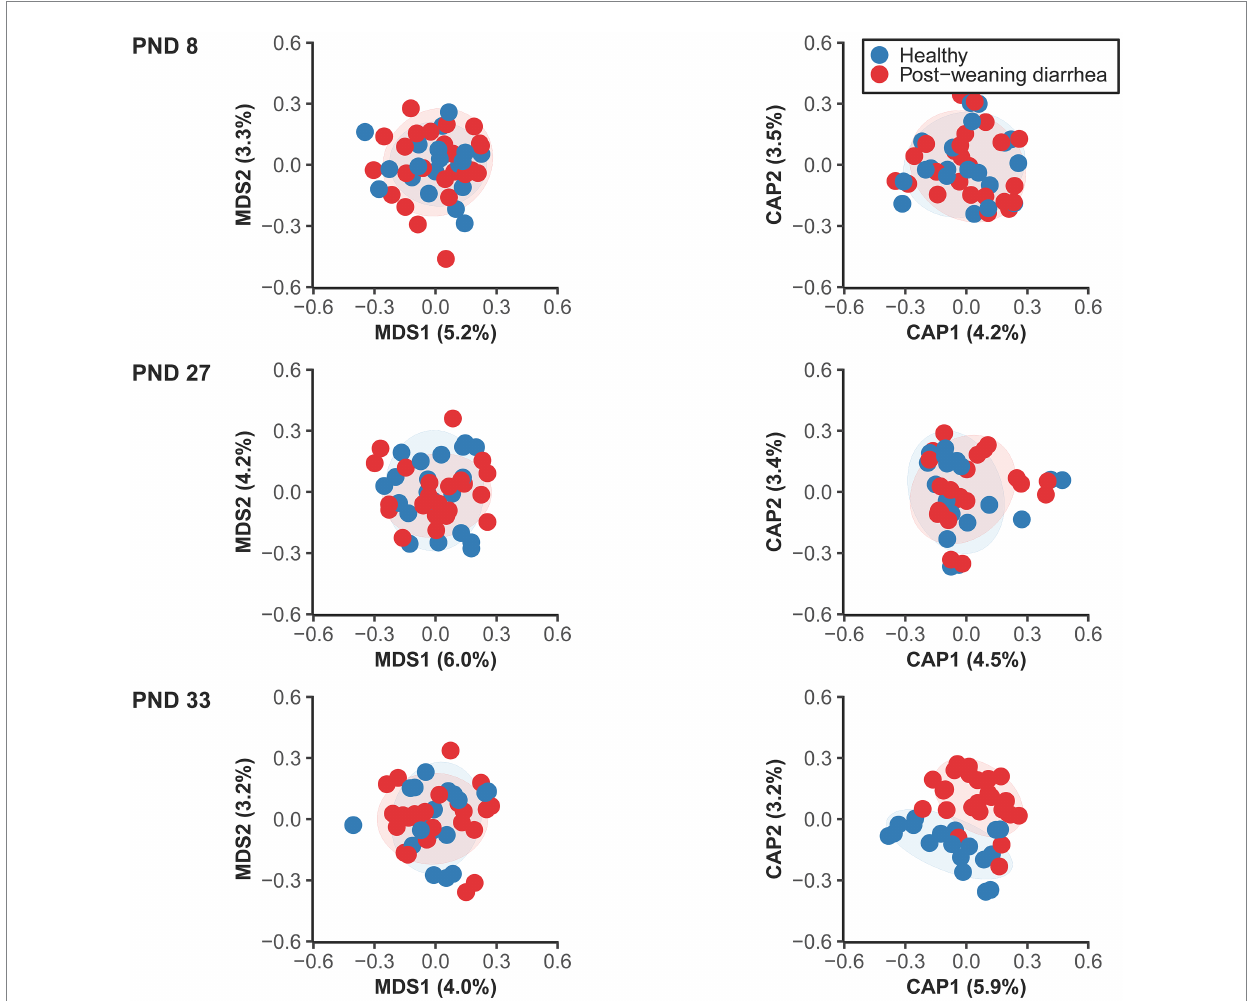
FIGURE 2 Unconstrained (left) and constrained ordination plots (right) of Canberra distance matrix of the fecal microbiome between healthy and post-weaning diarrhea (PWD) affected, at PND 8 (healthy: n = 20 pigs, PWD: n = 24 pigs), PND 27 (healthy: n = 20 pigs, PWD: n = 23 pigs), and PND 33 (healthy: n = 18 pigs, PWD: n = 25 pigs). Plots were created based on the rarefied zOTU table generated by 16S rRNA high throughput sequencing in the V3 region. Ellipses show 80% confidential areas assuming multivariate t-distribution. PERMANOVA was used to evaluate differences in distances at 999 permutations between the groups. Significant group difference in PWD status were found at PND 33: R 2 = 0.027, p = 0.009. In addition, there was a significant effect of the covariable body weight at PND 33: R 2 = 0.028, p =